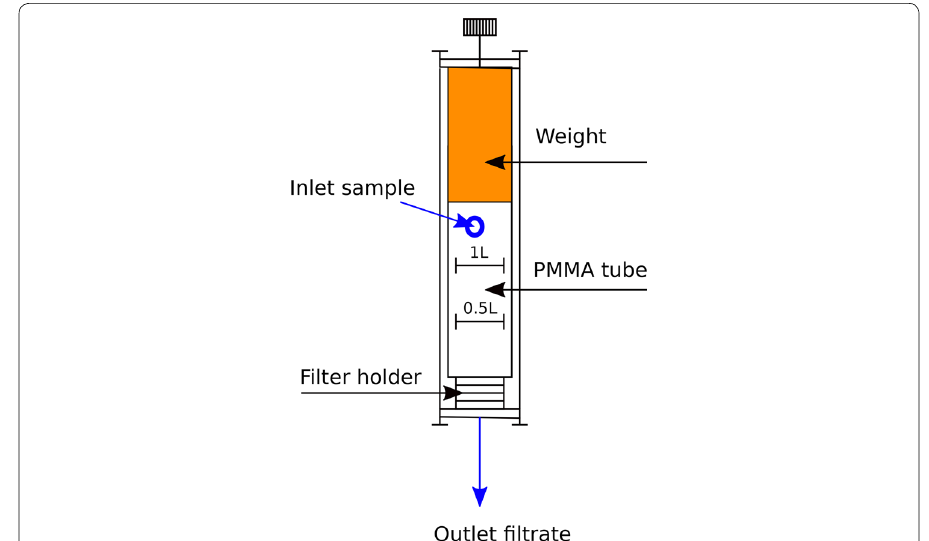
Fig. 4 Sketch of the filtration device used for particle size separation. A PMMA tube allows water filtration with reduced turbulences through PTFE filter holder. A weight pushing down on the water allows faster filtration at smaller pore